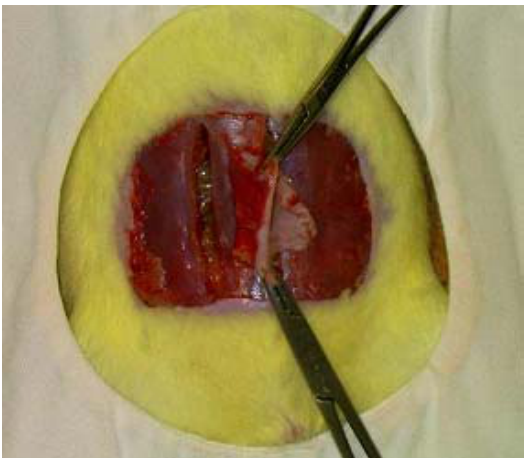
FIGURE 5: Longitudinal incision in the lateral margin of the chosen muscle.